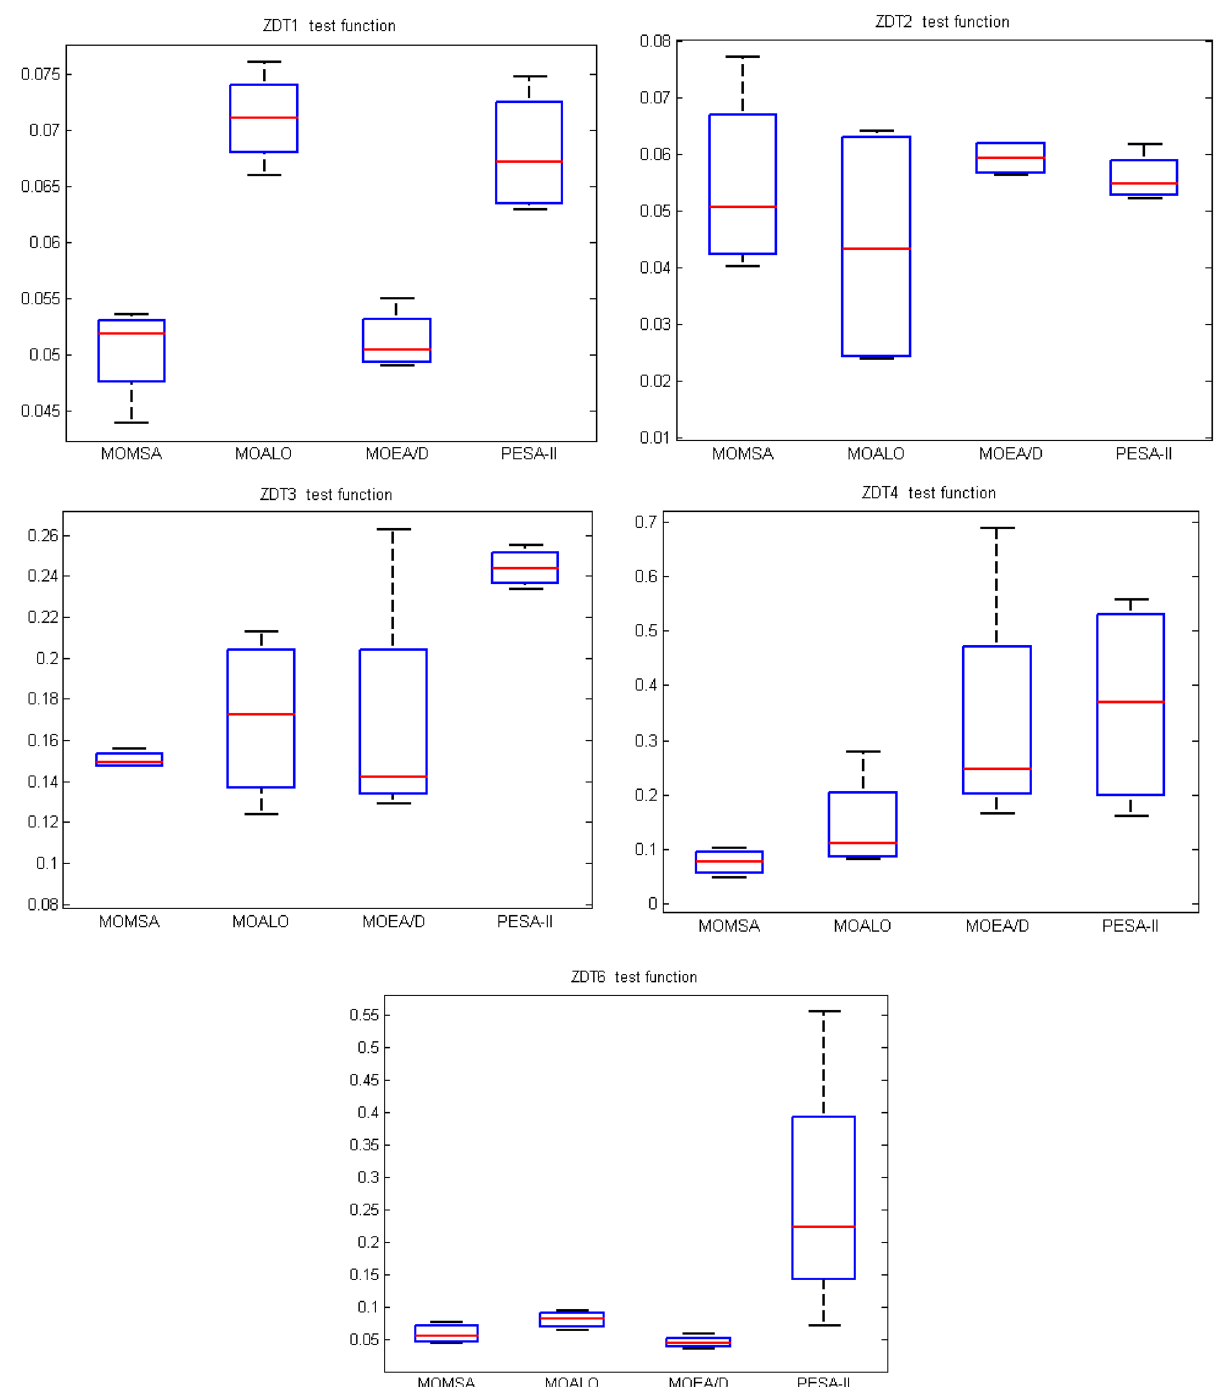
Figure 9. Boxplot of the statistical results for S evaluation metrics on ZDT bi-objective test function